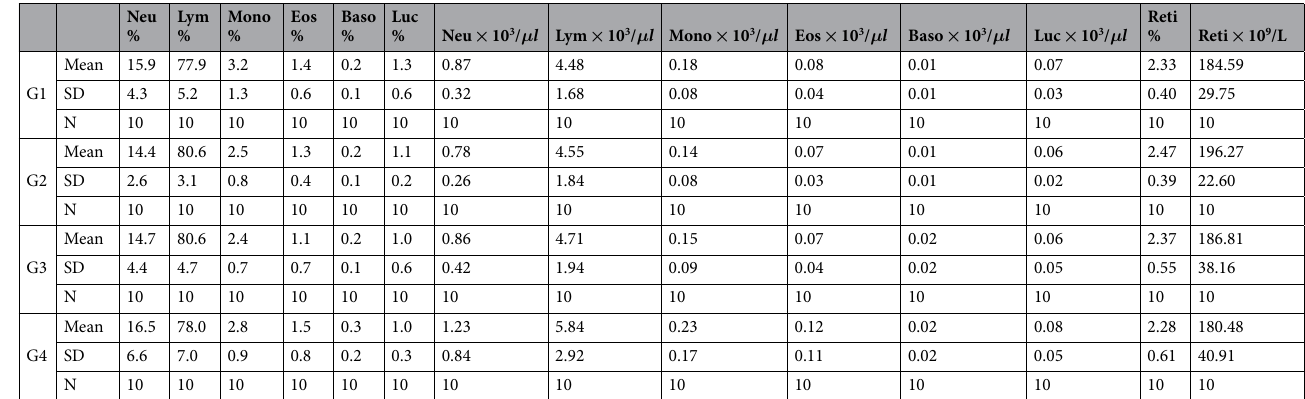
Table 4. Hematologic findings at 12 weeks (2). G: group, SD: standard deviation, N: number, Neu: neutrophils, Lym: lymphocytes, Mono: monocytes, Eos: eosinophils, Baso: basophils, Luc: large unstained cells, Reti: